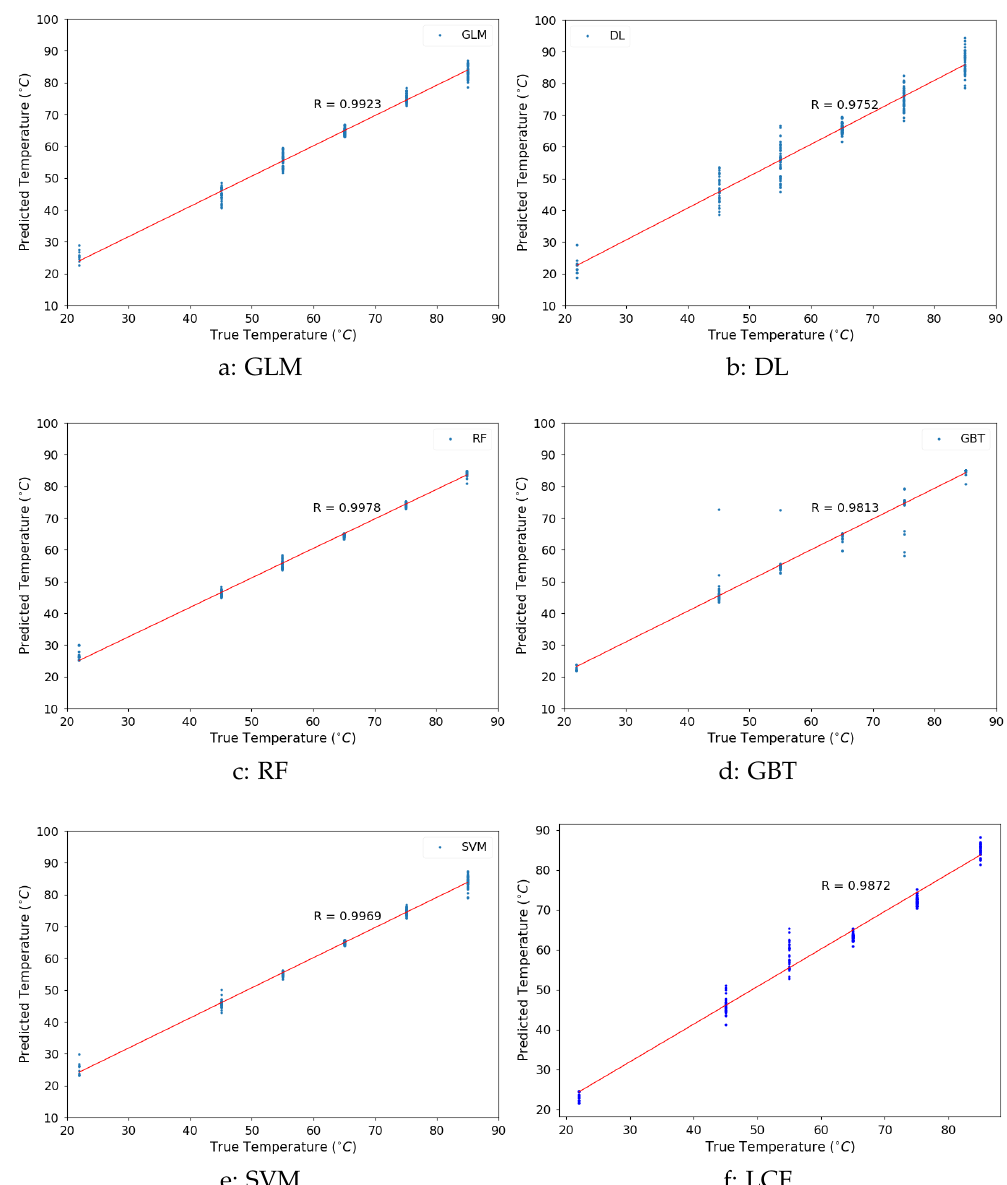
Figure 4. True vs. predicted temperature results by using k -fold cross validation for ML models ( a – e ) and by conventional LCF method ( f